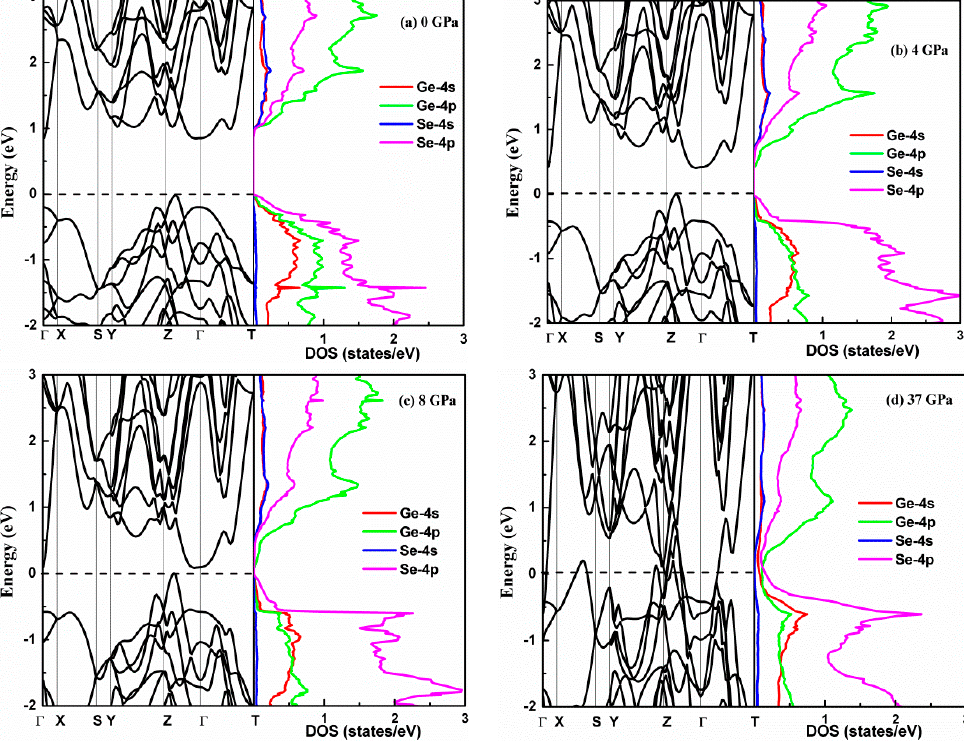
Figure 4. Band structure and projected density of states (DOS) of GeSe calculated at increasing simulated pressures: (a) 0 GPa; (b) 4 GPa; (c) 8 GPa; (d) 37 GPa.